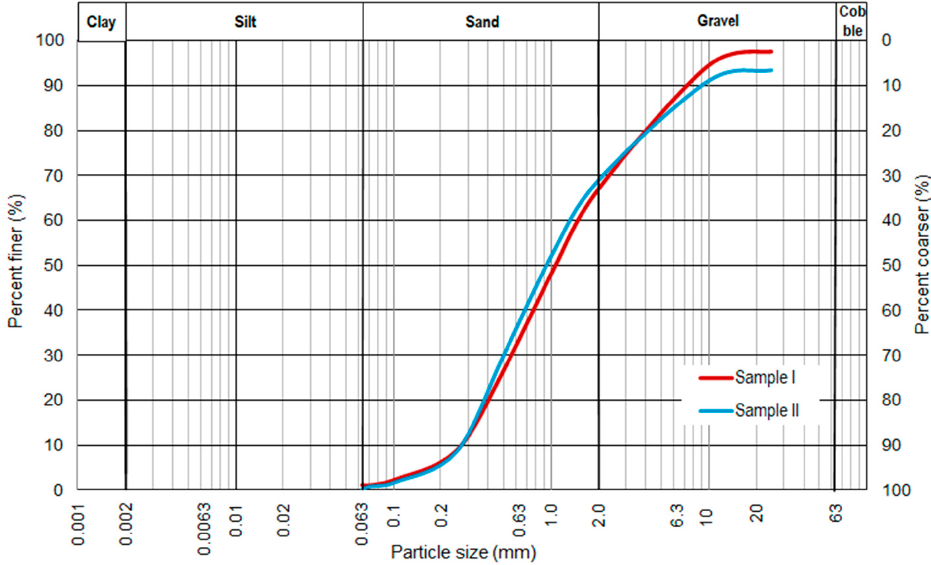
Figure 1. Grain-size distribution curves for research samples of non-cohesive soil.